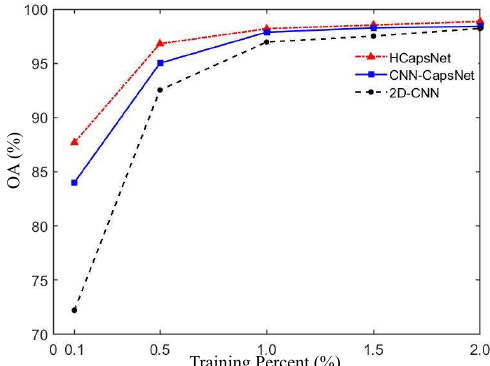
Figure 19. Classification accuracies with different training percentages on AIRSAR Flevoland